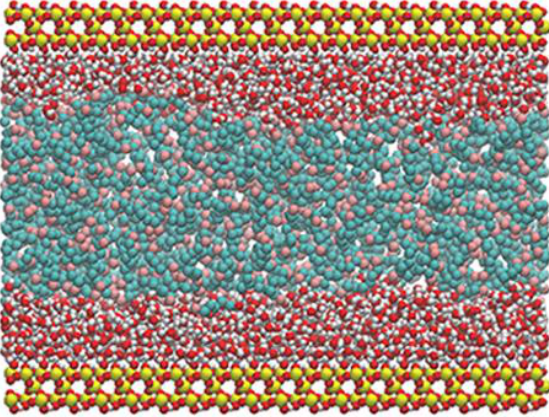
5 of 20 Figure 2. The process of the molecular simulation: ( a ) initial configuration and pore pressure control, ( b ) equilibrium configuration, ( c ) flow simulation. 2.2. Results of Molecular Simulation In this section, we analyze the static and dynamic properties of the oil – water two- phase fluid in quartz nanopores. The equilibrium configuration of oil and water in 5 nm quartz nanopores, with oil mass percentage (OMP) of 50%, is shown in Figure 3 as the example. The layered structure of water – oil – water is formed in quartz nanopores. To characterize the occurrence state of oil and water more accurately and intuitively, we pre- sent the density profiles and orientation order parameters of oil and water in 5 nm quartz nanopores in Figure 4. The orientation order parameter refers to the preferential orienta- tion of the molecules, which is defined as [50,51]: 𝑆(𝑧) = 3 2 〈cos 2 𝜃〉 − 1 2 (3) where θ is the angle between the molecule axis and the normal direction of the surface ( z - direction). For long-chain alkanes, θ refers to the angle between the head-to-tail line of the molecule and z -direction. For water, the molecule axis is defined as the line between the